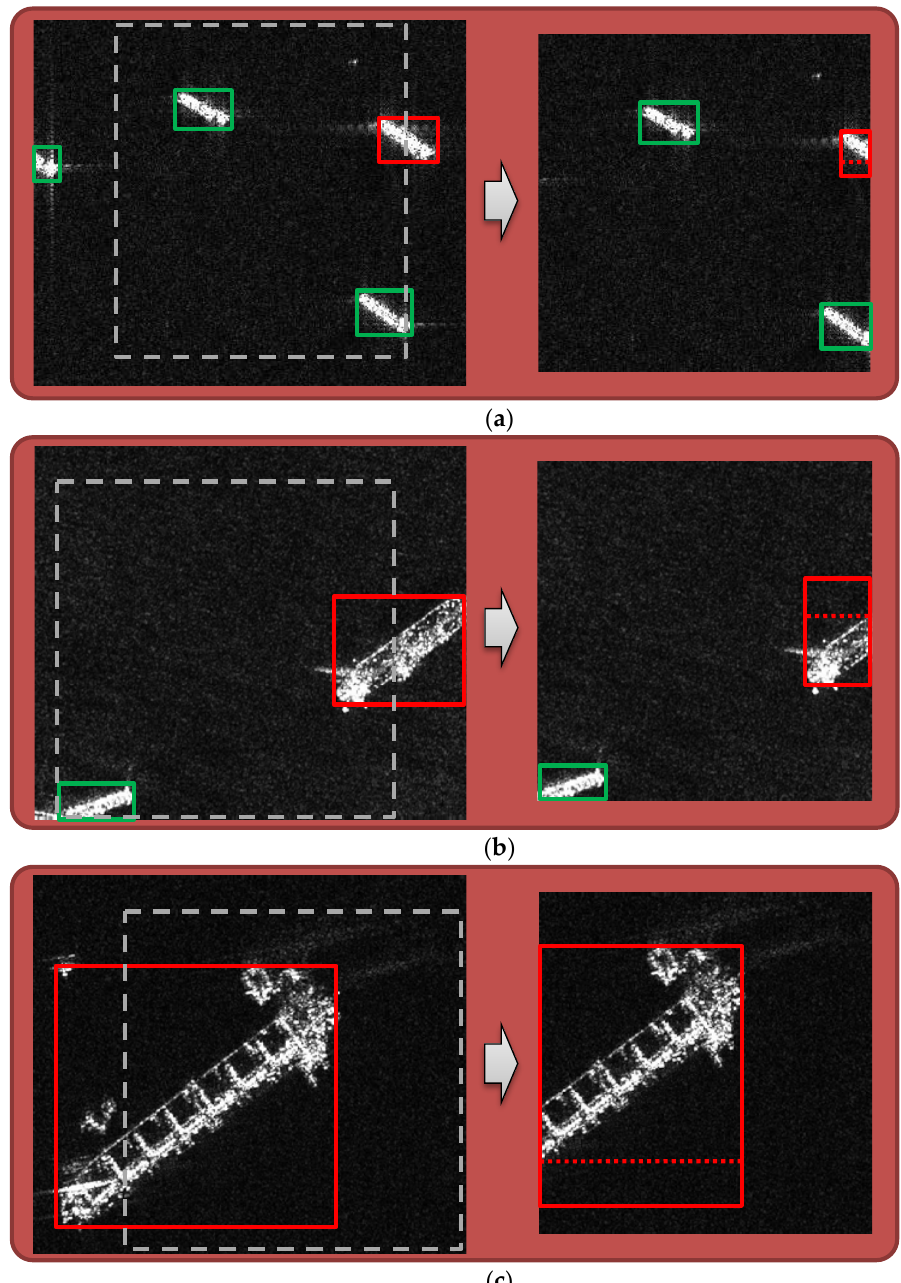
Figure 4. Three training samples of synthetic aperture radar (SAR) ship detection (left column) and examples of their random cropping results (right column). ( a ) Sample of small size targets. ( b ) Sample of medium size targets. ( c ) Sample of large size